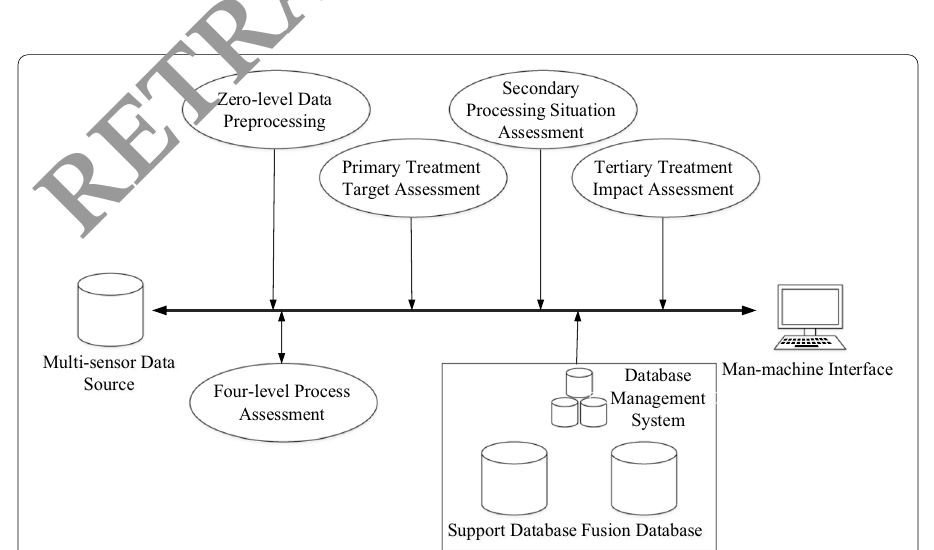
Fig. 2 Functional model diagram of multi-sensor information